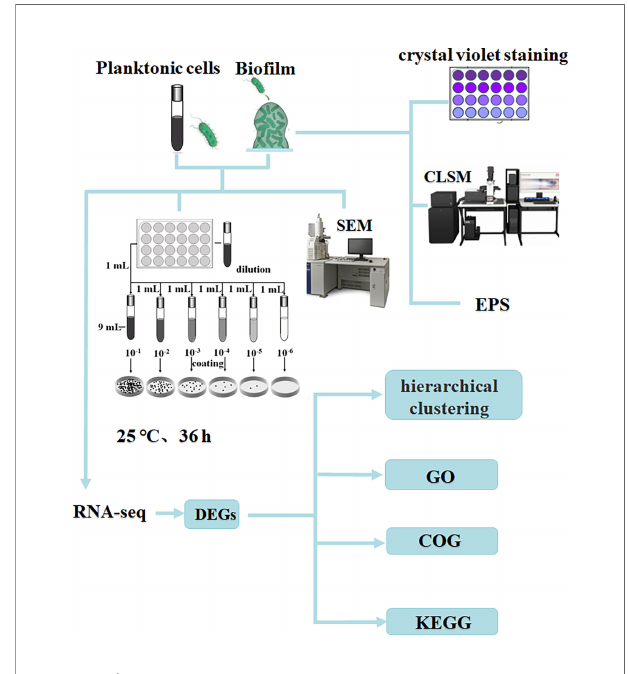
FIGURE 1 | Experimental fl ow